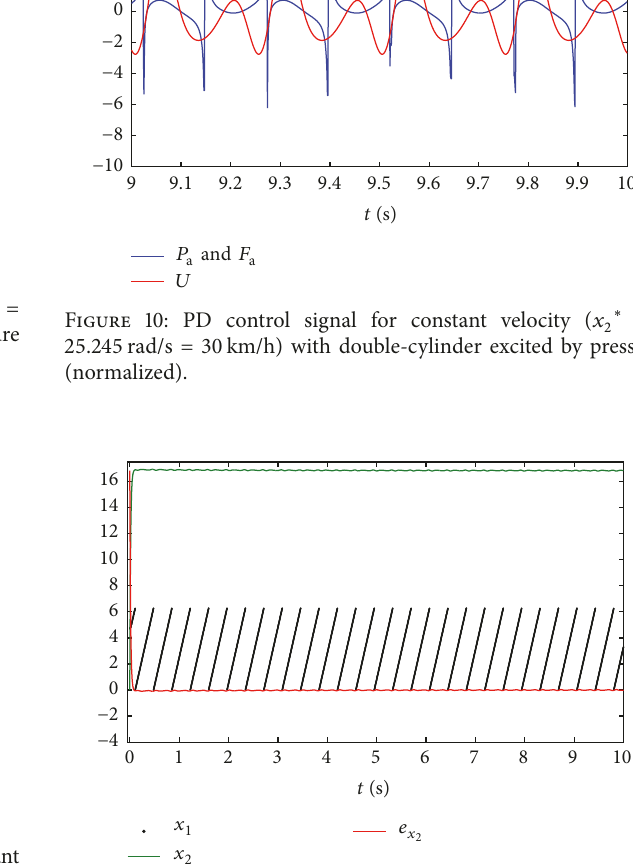
Figure9:Double-cylinderwithPDcontrolbypositionandconstant velocity ( 𝑥 2∗ = 25.245 rad/s = 30km/h).